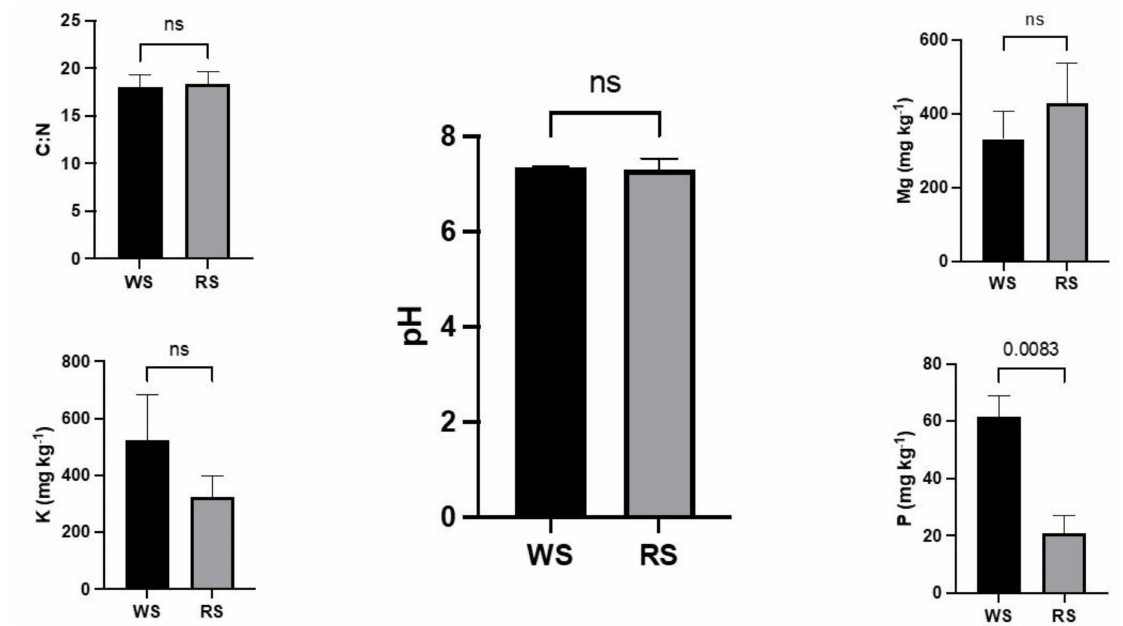
Figure 4. Results of Dactylorhiza incarnata subsp. ochroleuca wild site soil showing C:N, pH, and other minerals in mg/Kg of soil. Data analyzed following an unpaired t -test with Welch’s